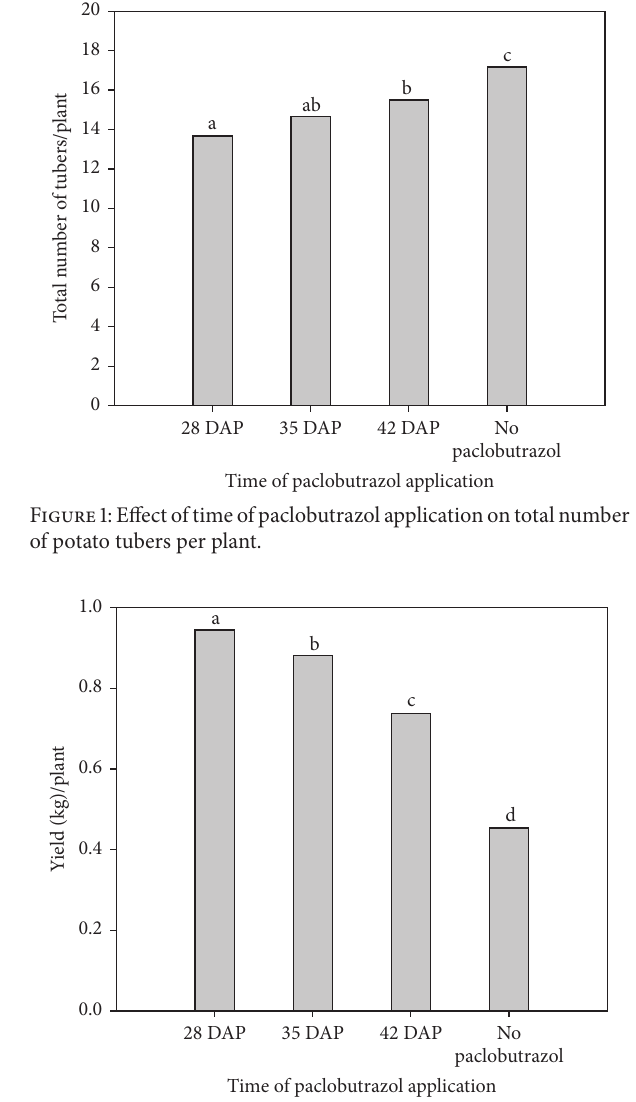
Figure 2: Effect of time of paclobutrazol application on potato tuber yield (kg) per